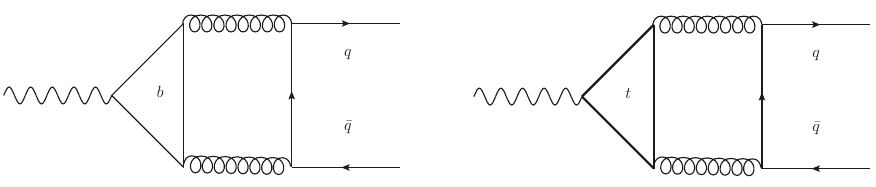
Figure 1 . Samples of singlet diagrams at 2-loop